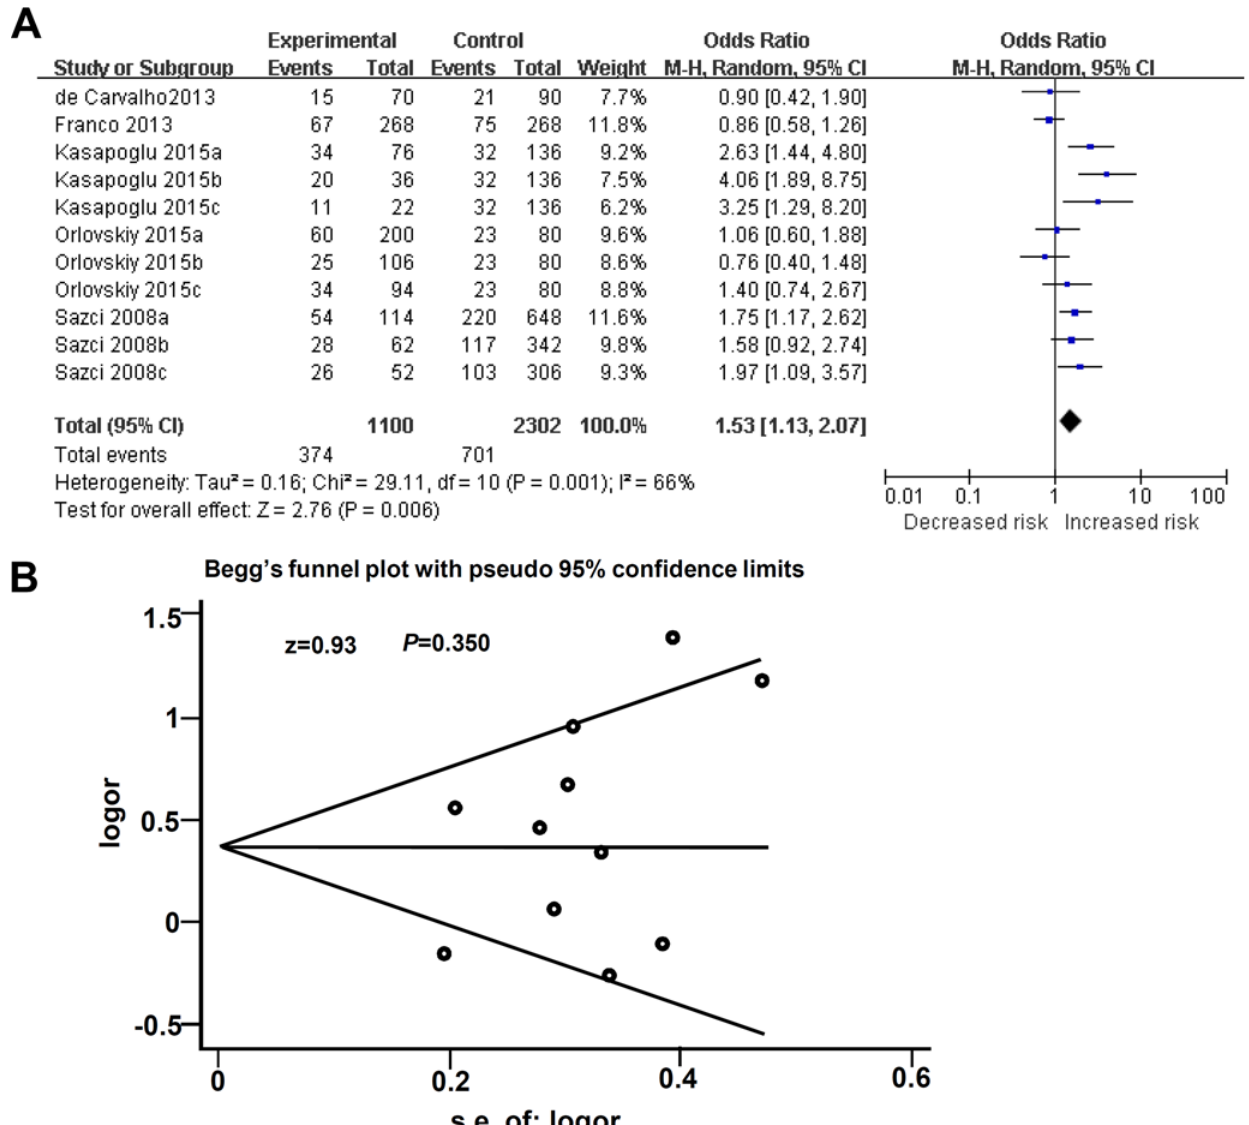
Fig 4. Meta analysis for the association between A1298C allele frequency of MTHFR and the risks of NAFLD. (A) Forest plot under C vs A model; (B) Begg ’ s funnel plot of publication biases under C vs A